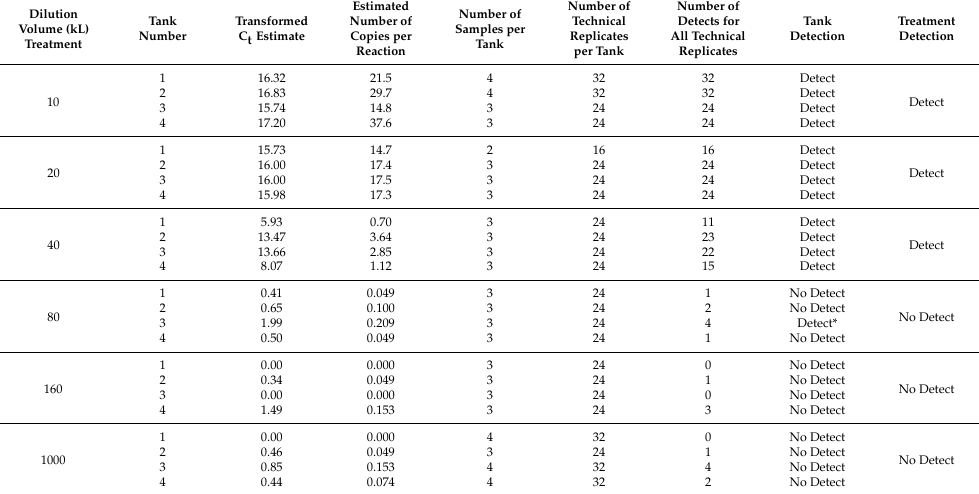
Table 5. The interpretation of Detect or No Detect of coho salmon DNA from eONKI4 in the dilution experiment at the Goldstream Hatchery in the presence of an environmental background eDNA signal. One Detect* was found at the tank level in the 80 kL treatment, which suggest that target DNA may be present, but more sampling is recommended to confirm the result. The remaining tanks at 80 kL were assessed as No Detect, which leads to a treatment level conclusion of No Detect.